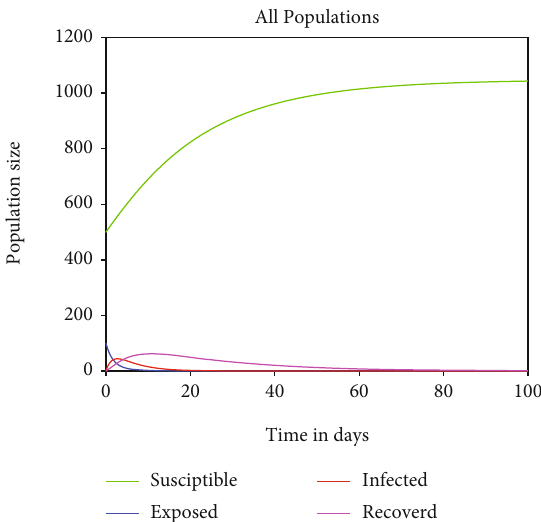
Figure 2: Solutions of the COVID-19 submodel with parameter values Λ = 500 , β 2 = 0 : 054 , μ = 0 : 0477 , φ = 0 : 46 , δ C = 0 : 0023 ψ = 0 : 2065 , ω = 0 : 09 , and its basic reproduction number R C < 1